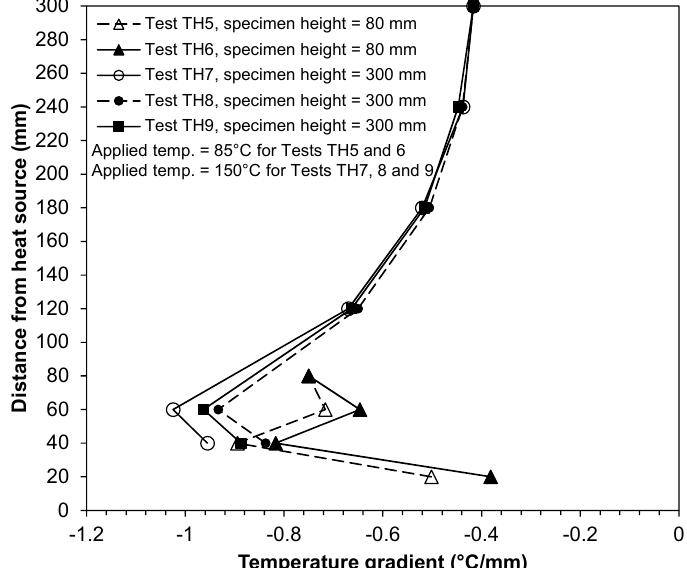
Figure 11. Temperature gradient at various distances from the heat source for non-isothermal hydraulic tests at 85 °C and 150 °C.